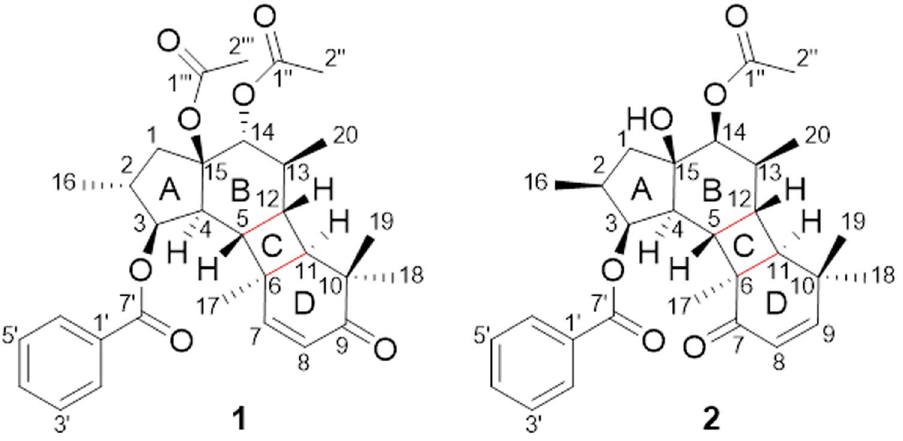
Figure 1. Structures of 1 and